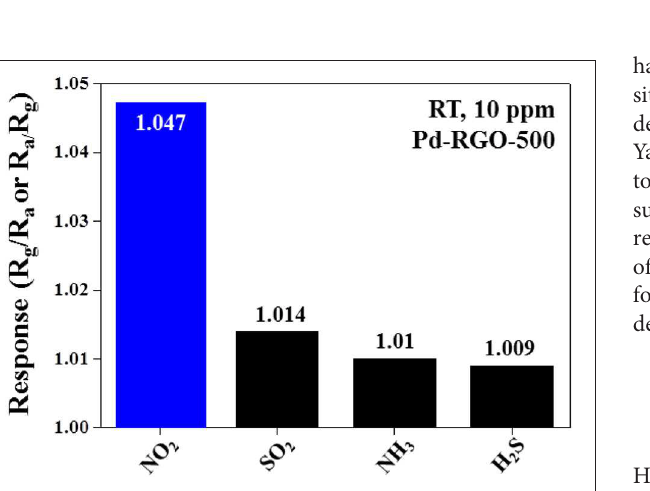
FIGURE 10 | Selectivity pattern of the Pd-RGO-500 gas sensor to 10 ppm of different gases at room temperature.